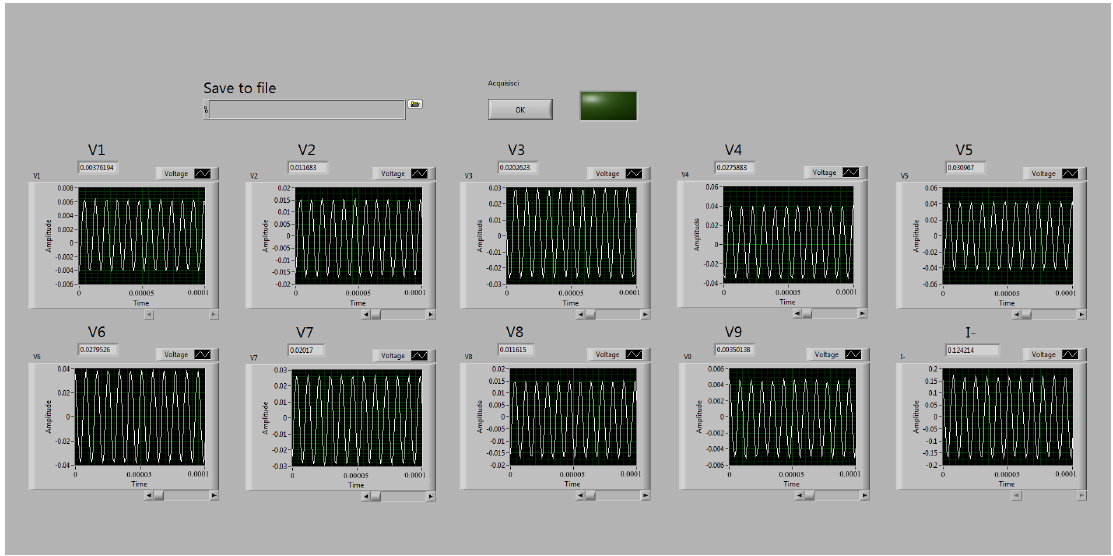
Figure 3. Control panel, developed in LabView, to control the sensor